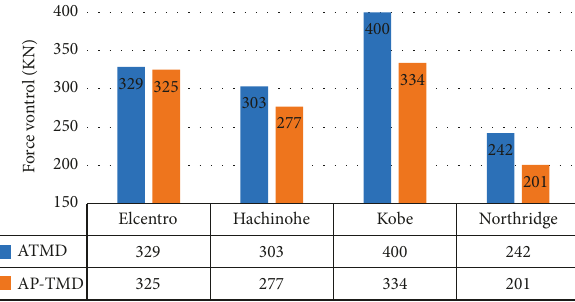
Figure 14: The control Force of AP-TMD and ATMD.